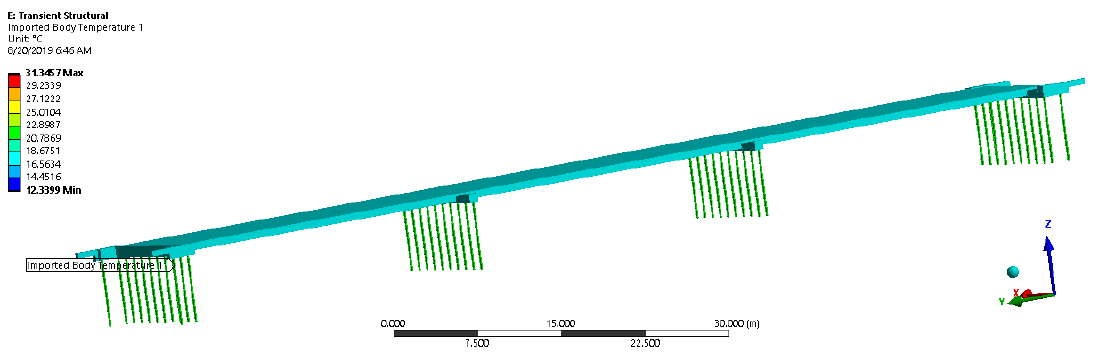
Figure 8. Temperature contour of the integrated concrete bridge in the first month of the year. Table 4. Thermal analysis results of the integrated concrete bridge subjected to temperature variations. Month